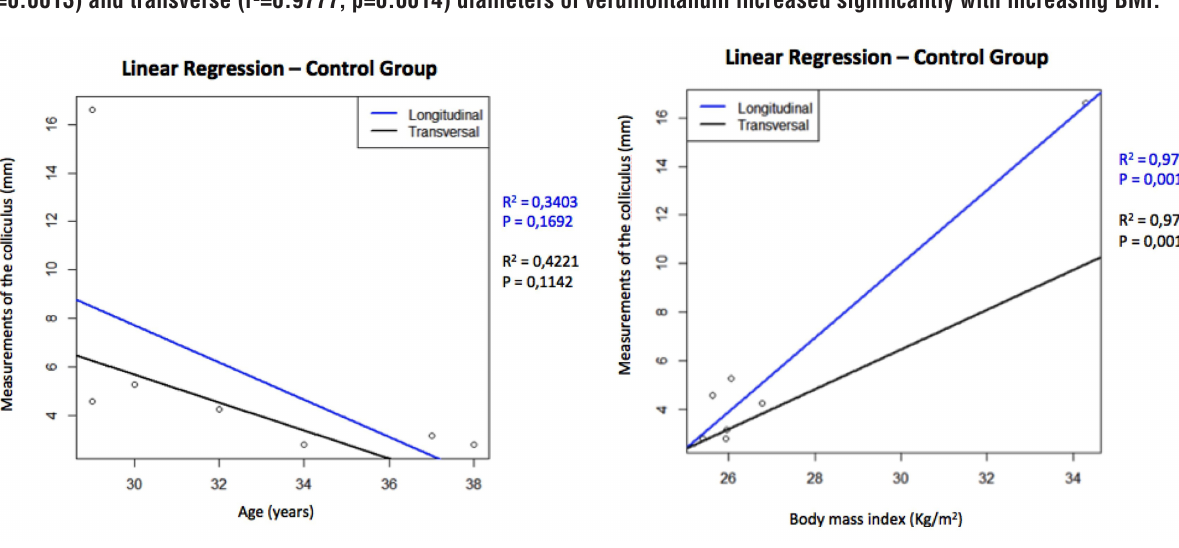
Figure 2 - The figure shows the linear regression graphs of the control group comparing the age (years) and BMI (kg/m 2 ) variables with the verumontanum measurements. Linear regression demonstrates that the longitudinal (r 2 =0.3403; p=0.1692) and transverse (r 2 =0.4221; p=0.1142) diameters of verumontanum decreased with age. The longitudinal (r 2